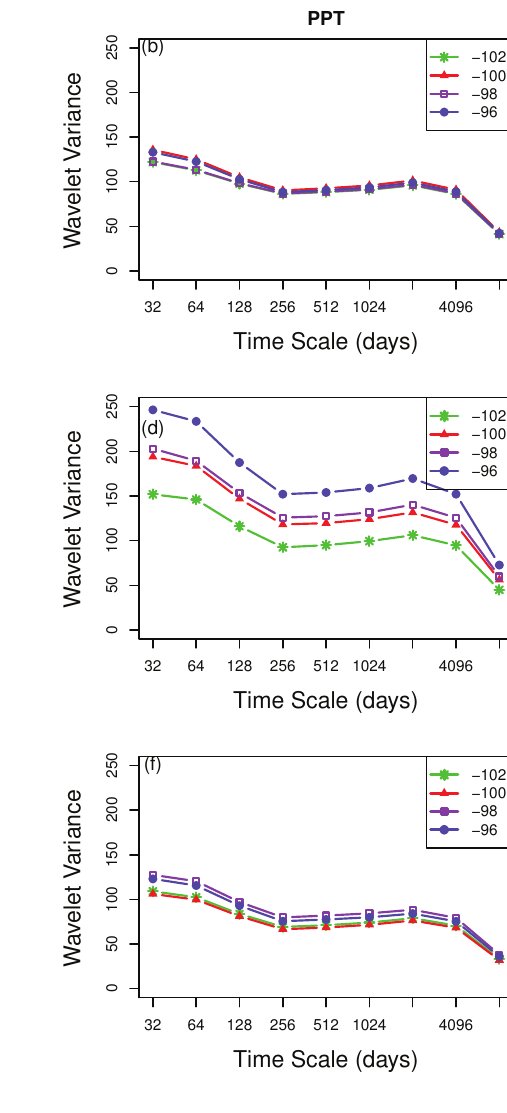
in ( a ) entire KRB; ( b ) whole KRB; ( c , d ) irrigated corn; ( e , f ) C4 grassland; for selected longitudes: 102 W (green line with star), 100 W (red line with triangle), 98 W (purple line with rectangle) and 96 W (blue line with